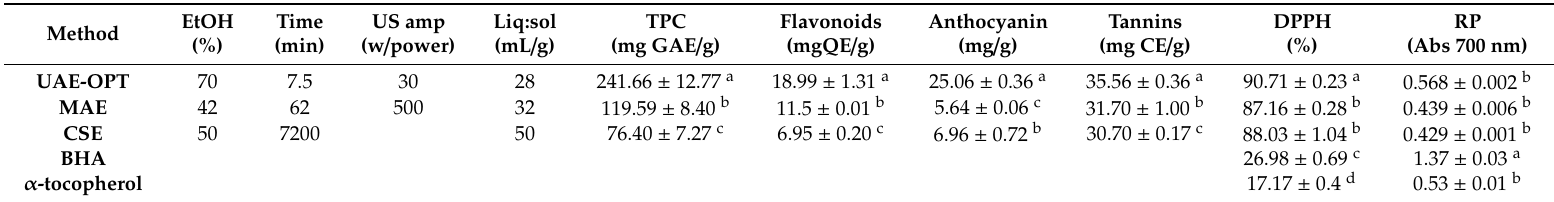
Table 3. Comparison of extraction yield of polyphenols obtained by optimized ultrasound-assisted (UAE-OPT), microwave-assisted (MAE) and conventional solvent (CSE)